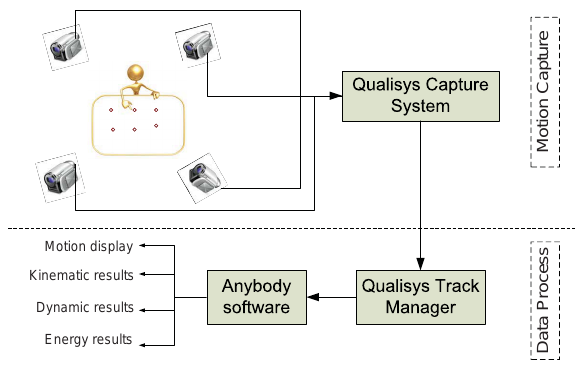
Figure 1: Experimental system for human arm motion capture and analysis